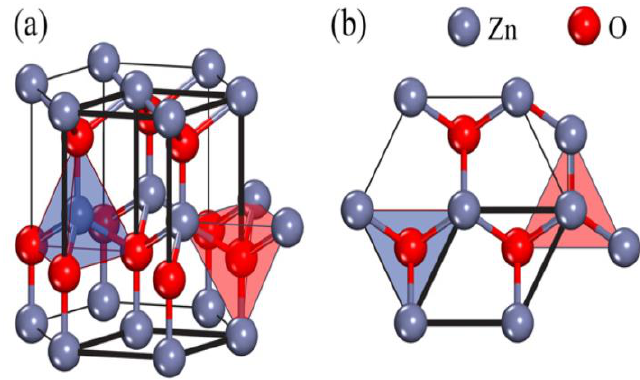
Figure 3. ( a ) Side view and ( b ) top view of ZnO wurtzite structure. Reproduced from [43] with permission of Elsevier.